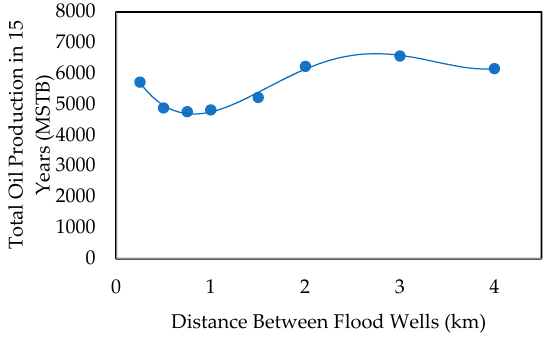
Figure 15. Variation of oil production with distance between injecting wells.